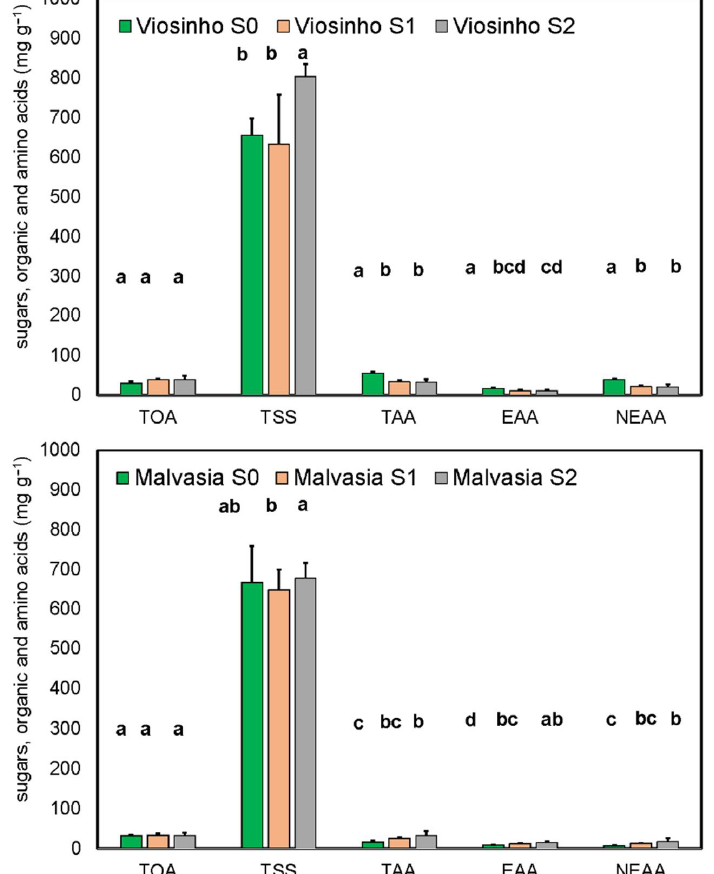
Figure 2. Contents of total organic acids (TOA), total sugars (TSS), total amino acids (TAA), essential amino acids (EAA), and non-essential amino acids (NEAA) in berries of Viosinho and Malvasia-fina grapevine varieties healthy (S0; severity level 0), moderately (S1; severity level 1) and severely (S2; severity level 2) affected by esca complex disease. Error bars represent standard deviation over three replications. Comparing the two varieties, value bars with different letters for each parameter are different (Turkey’s test, p ≤